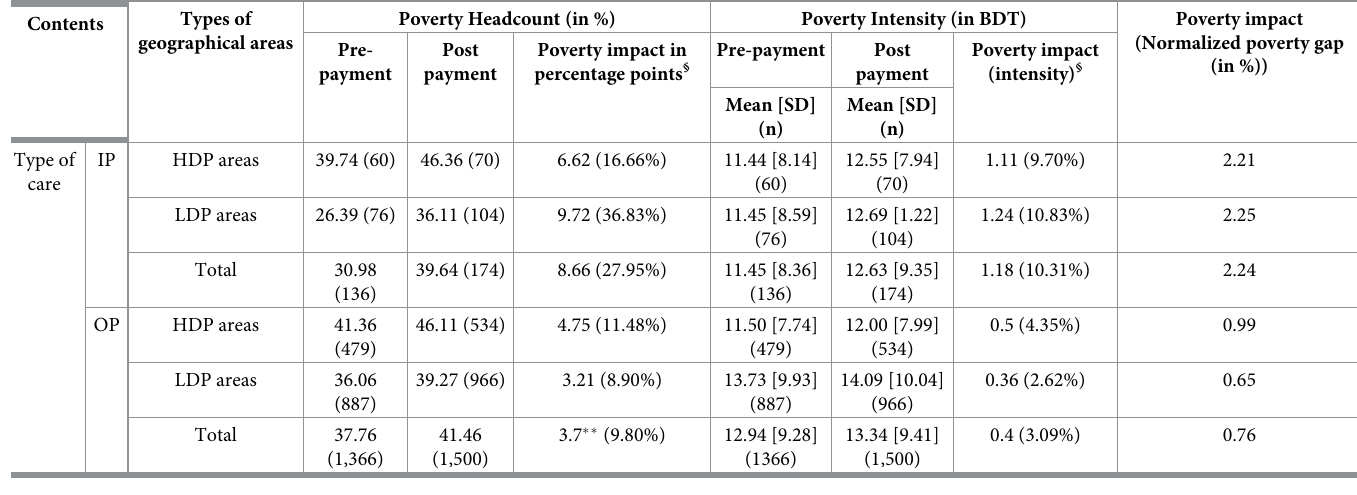
Table 7. Impact of OOP payments on poverty by types of cares and geographical areas.